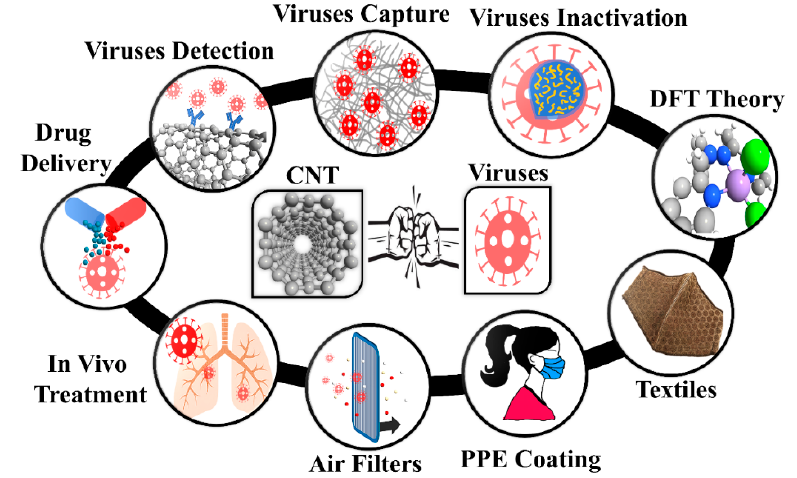
Figure 1. Carbon nanotubes in different segments of viral capture/inactivation. PPE: Personal Protective Equipment; CNT: Carbon nanotubes; DFT: Density Functional Theory.